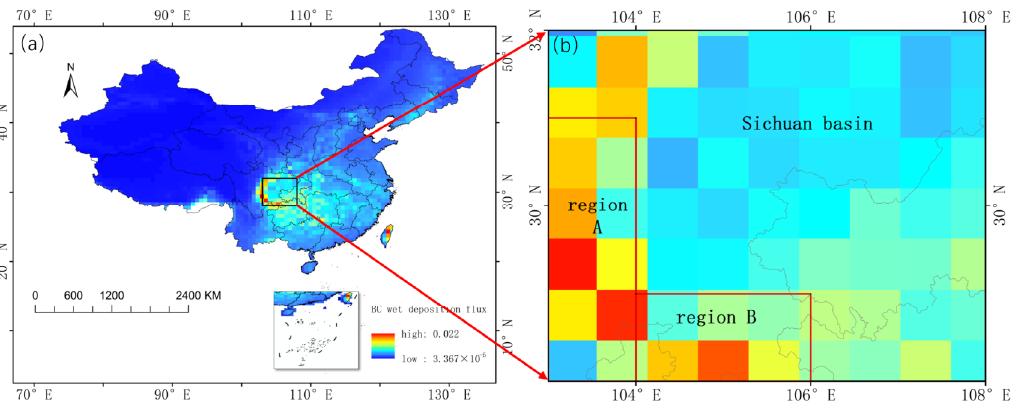
Figure 1. Location of the site selected in this study ( a ). Black box denotes the study area of the Sichuan basin (28° N–32° N, 103° E–108° E) in China ( b ). Red boxes denote the study areas with high BC wet deposition values over the western (region A) and southern (region B) parts of Sichuan Basin. Unit: μg m −2 s −1 .